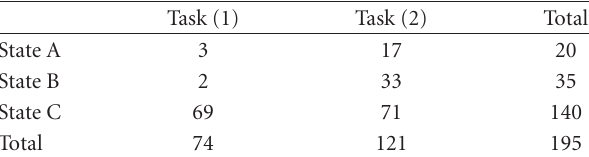
Table 2: Evaluation results (Majority).